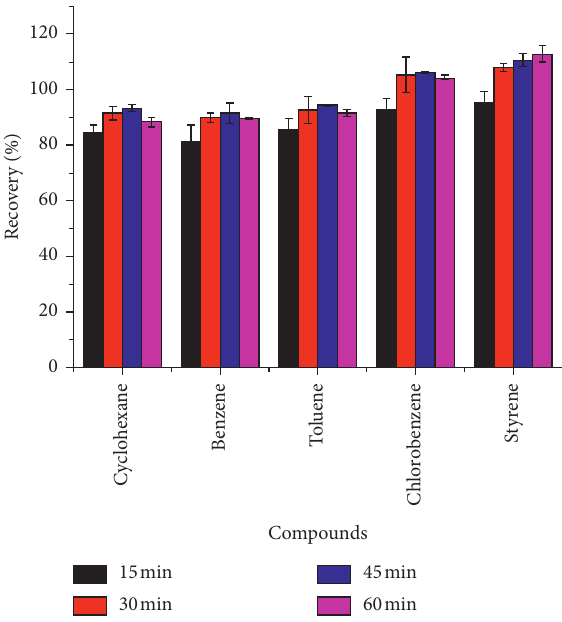
Figure 5: Effect of extraction time on extraction efficiency of soy